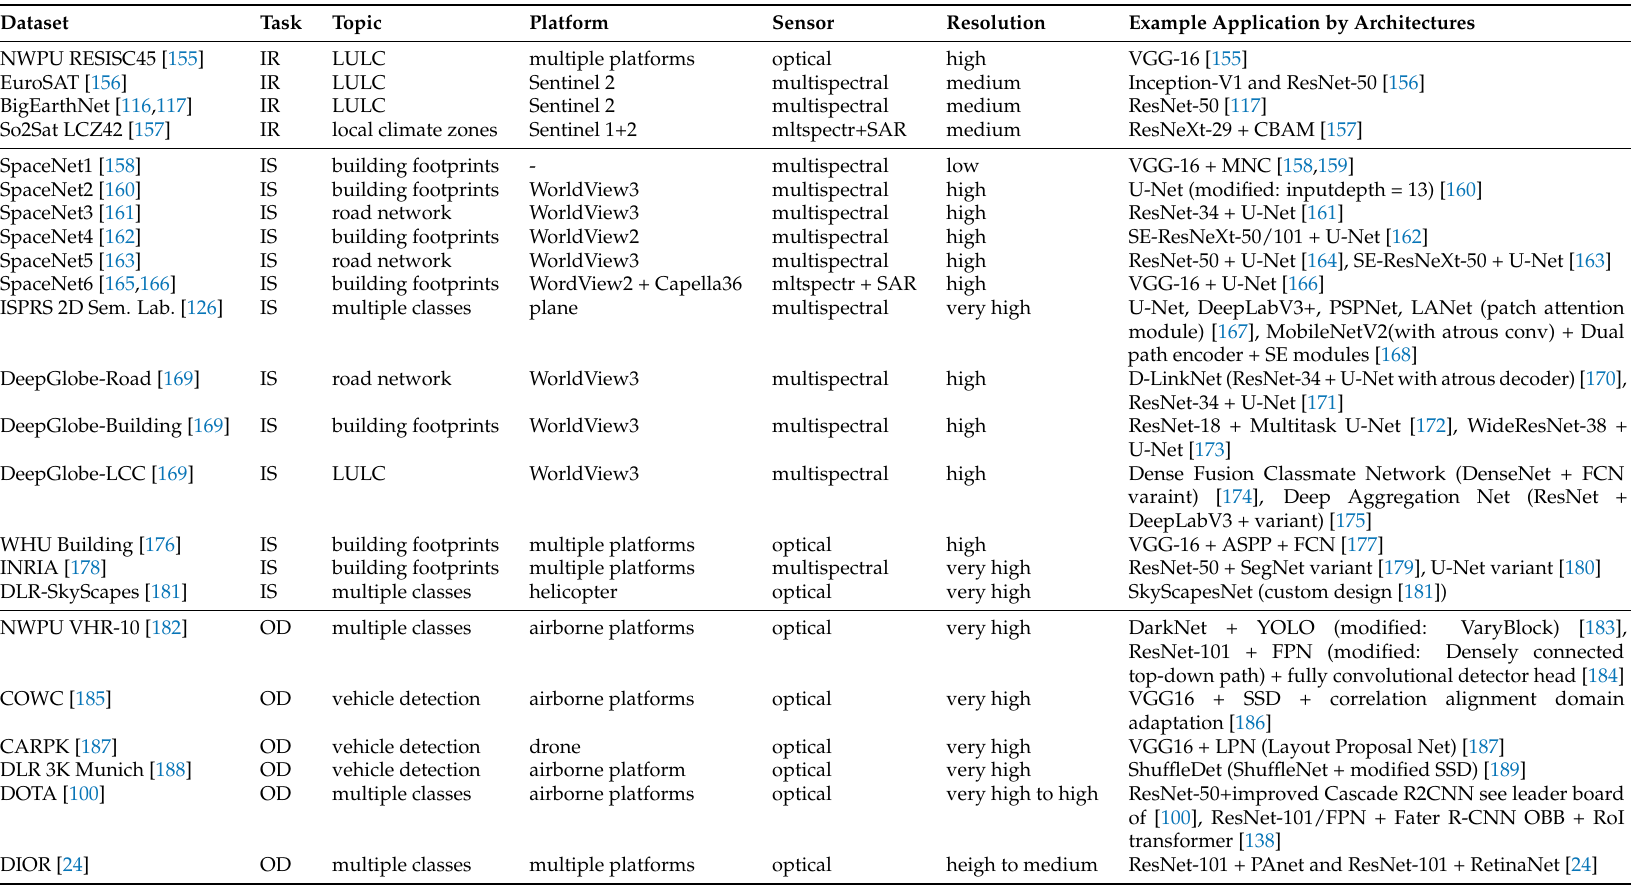
Table 5. Summary of DL datasets, with abbreviations for longer names, grouped by their tasks image recognition (IR), image segmentation (IS) and object detection (OD). In the column Topic, the abbreviation LULC means Land Use Land Cover classification. All datasets are freely available, with the need to contact the author for a few of them. The last column shows example applications by briefly describing the